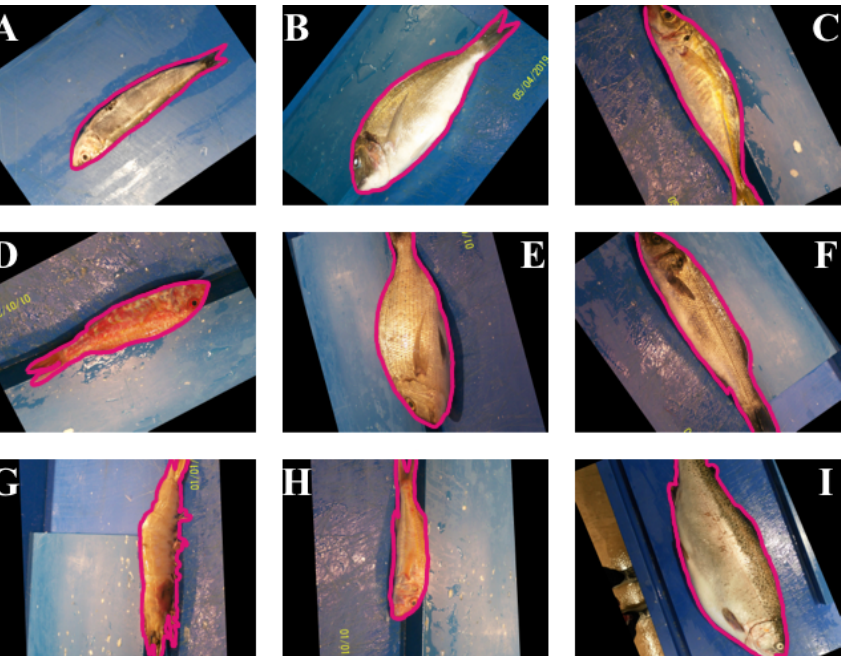
Figure 2. Dataset visualization. ( A – I ) shows multiple targets and multiple scales of the dataset: ( A ) is Black Sea Sprat; ( B ) is Gilt-Head Bream; ( C ) is Hourse Mackerel; ( D ) is Red Mullet; ( E ) is Red Sea Bream; ( F ) is Sea Bass; ( G ) is Shrimp; ( H ) is Striped Red Mullet; ( I ) is